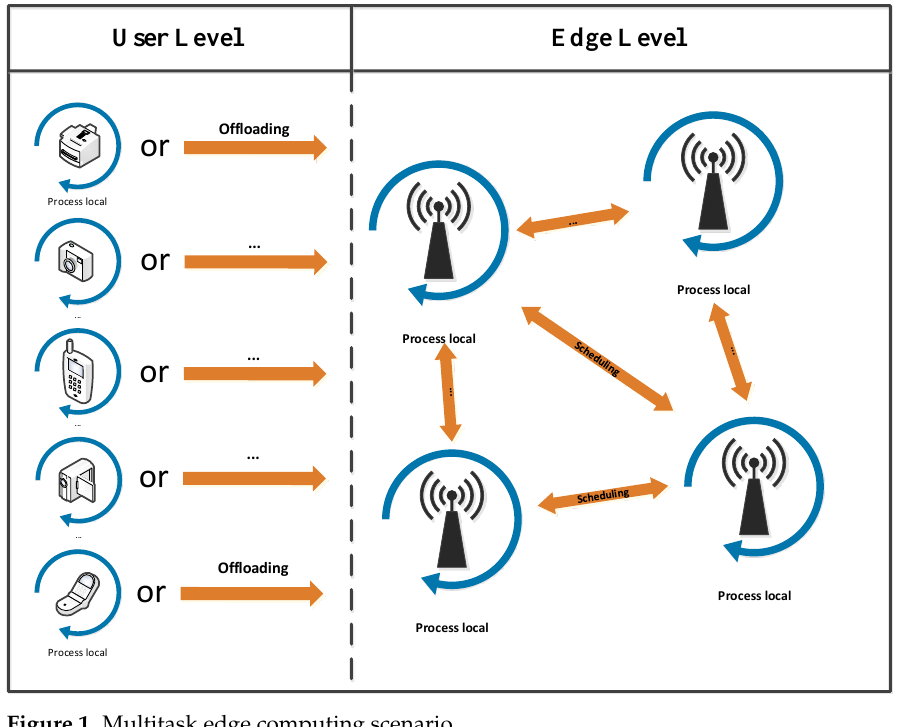
Figure 1. Multitask edge computing scenario.